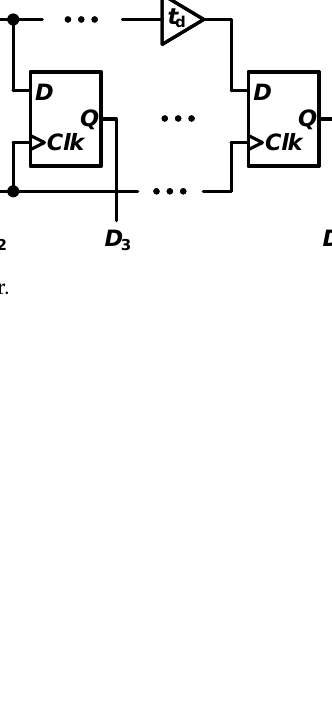
Figure 6. The linearity of proposed TDC-Based